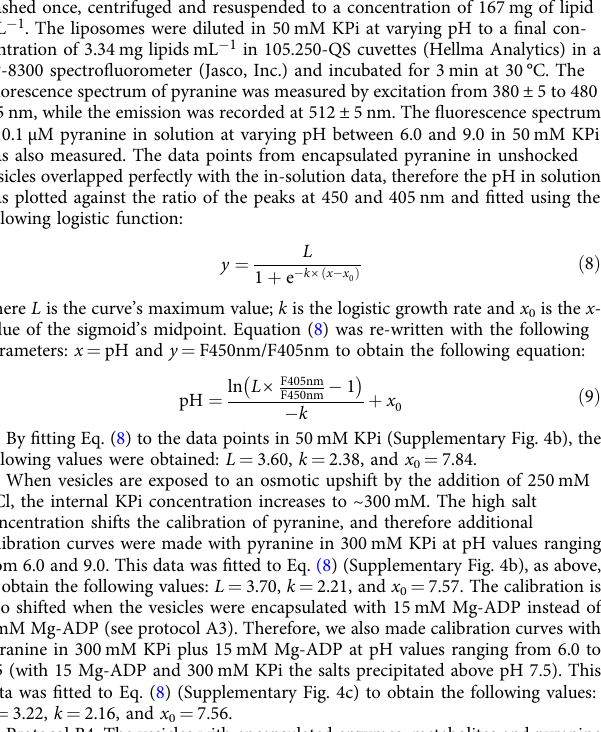
Protocol B4: The vesicles with encapsulated enzymes, metabolites and pyranine were diluted in buffer I to a fi nal concentration of 3.34 mg lipids mL − 1 in